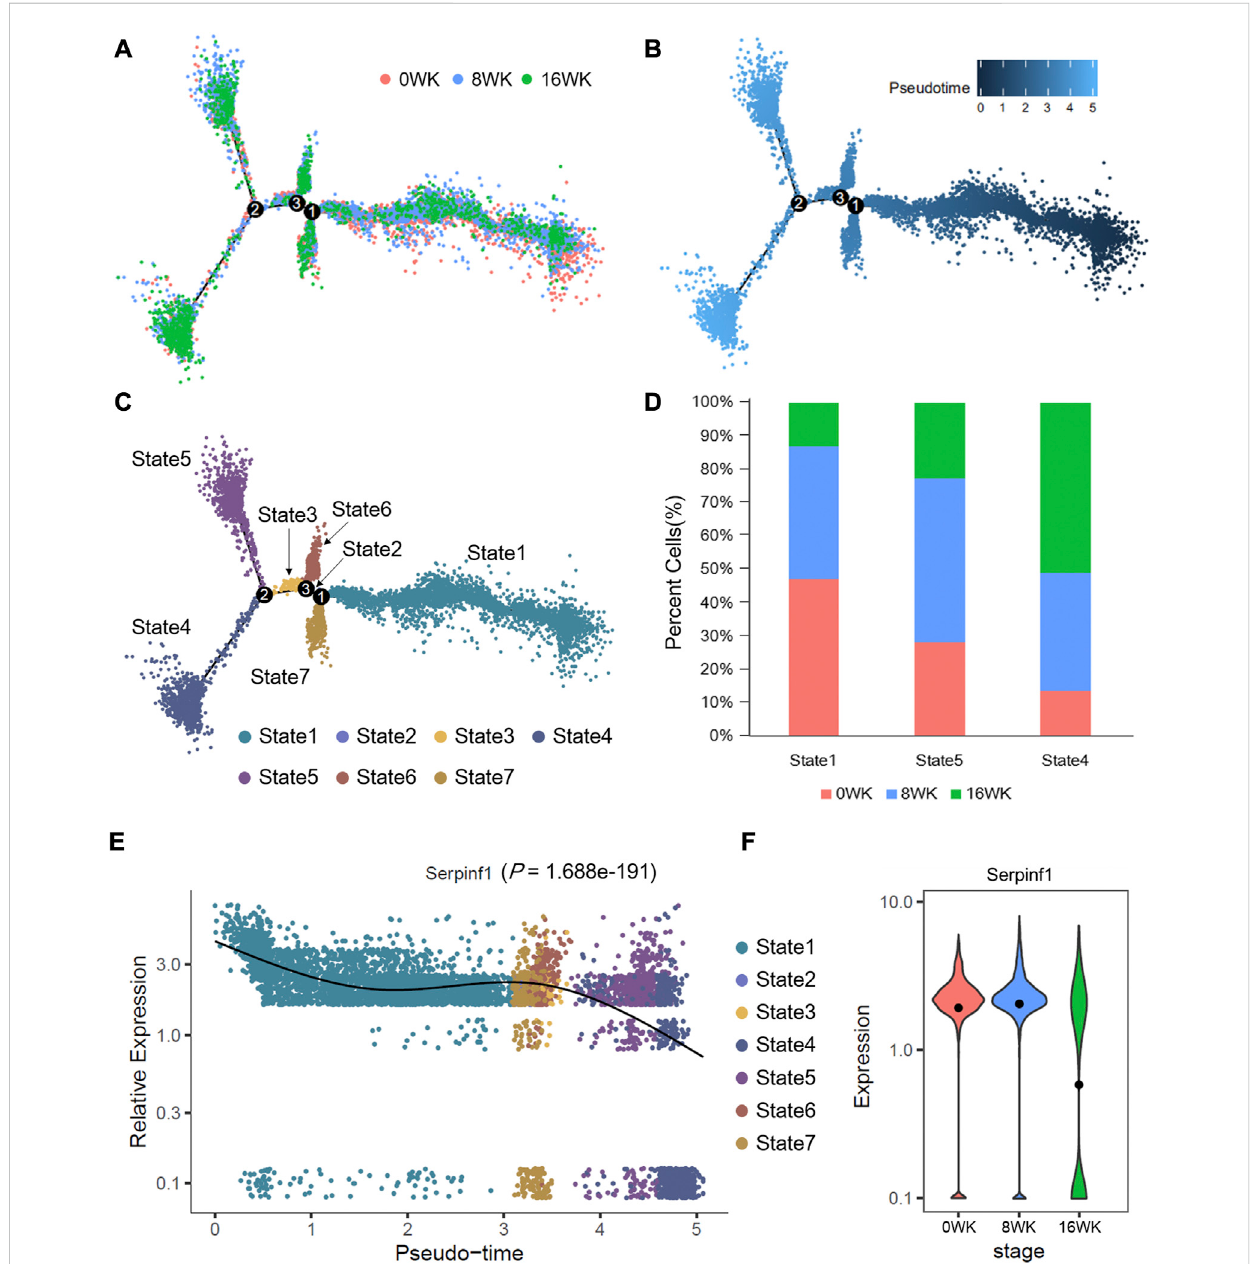
FIGURE 5 Pseudotime trajectories analysis of fi broblasts and fi bromyocytes in mouse atherosclerosis arteries. Pseudotime trajectories of cells (6,811 cells in total) colored by (A) disease stages, (B) pesudotime value, and (C) cell states. (D) The proportion of cells in state1, state4, and state5. (E) The expression dynamics of Serpinf1 is showing with thepseudo-time and cell states. p -value is bylikelihood ratiotests. (F) The log e (TPM+1) expressionlevel of Serpinf1 in three stages. The black dots represent the average expression level. The data of this fi gure is from